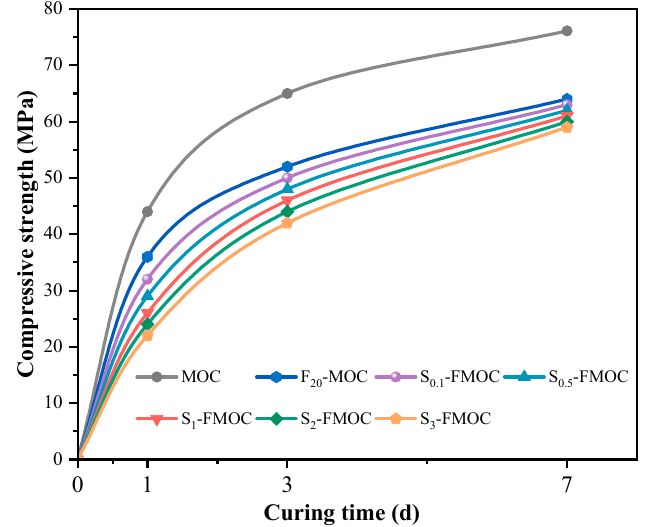
Figure 9. Effects of fly ash and HDTMS on the development of compressive strength of MOC.